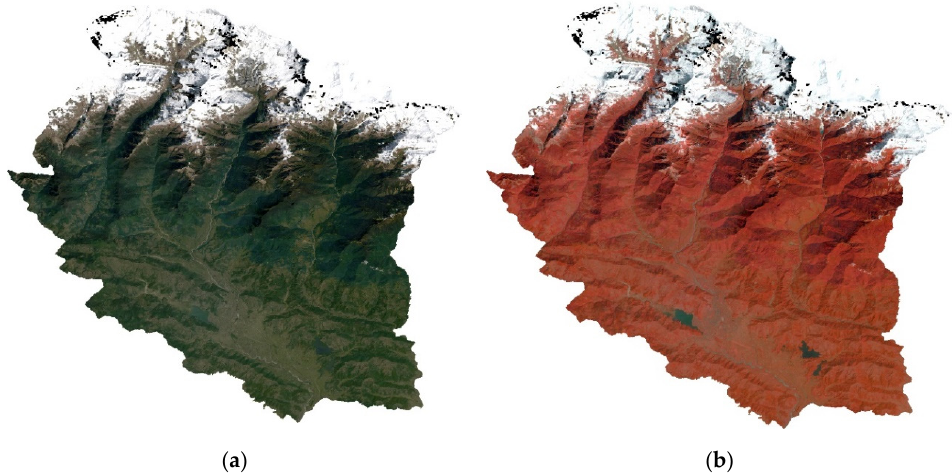
Figure 5. Median composite of the clipped Landsat scenes of Kaski District for the year 2020. ( a ) True-